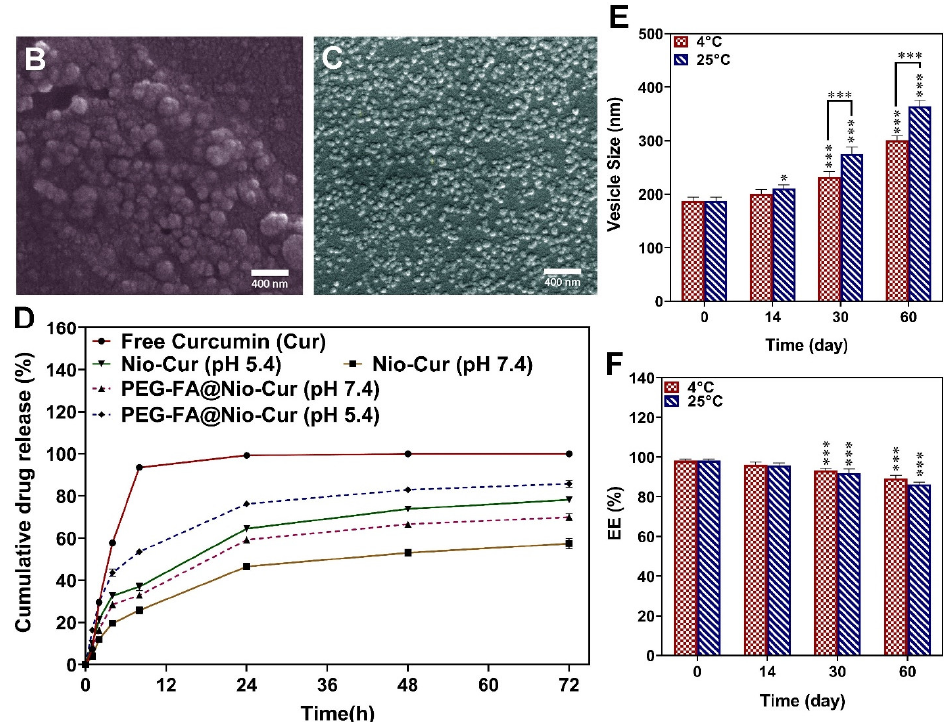
Figure 2. ( A ) The preparation of functionalized niosomes by the thin-layer hydration method. MLV: multilamellar vesicles; SUV: small unilamellar vesicles; ( B ) SEM image of the prepared optimized Nio-Cur3; ( C ) SEM image of the prepared optimized PEG-FA@Nio-Cur3; ( D ) In vitro release of Cur from Nio-Cur3 and PEG-FA@Nio-Cur3 at pH 7.4 and pH 5.4 in 37 °C; ( E ) Size stability evaluation of PEG-FA@Nio-Cur3 and ( F ) EE (%) stability evaluation of PEG-FA@Nio-Cur3 after two months of storage at 4 ± 2°C and 25 ± 2 °C; Data are represented as mean ± SD and n = 3; p < 0.001 ***, p < 0.05 *.